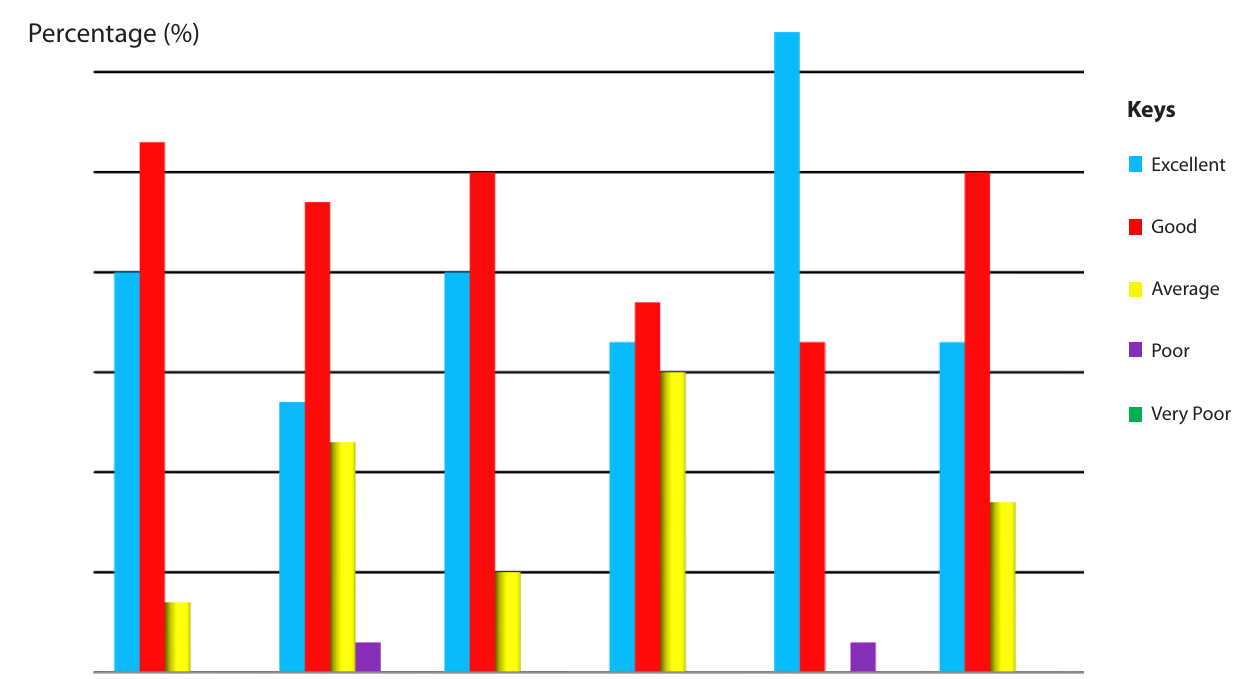
Fig. 3.1 - Scoring of the heart model on accuracy and usefulness in the future (n=30).